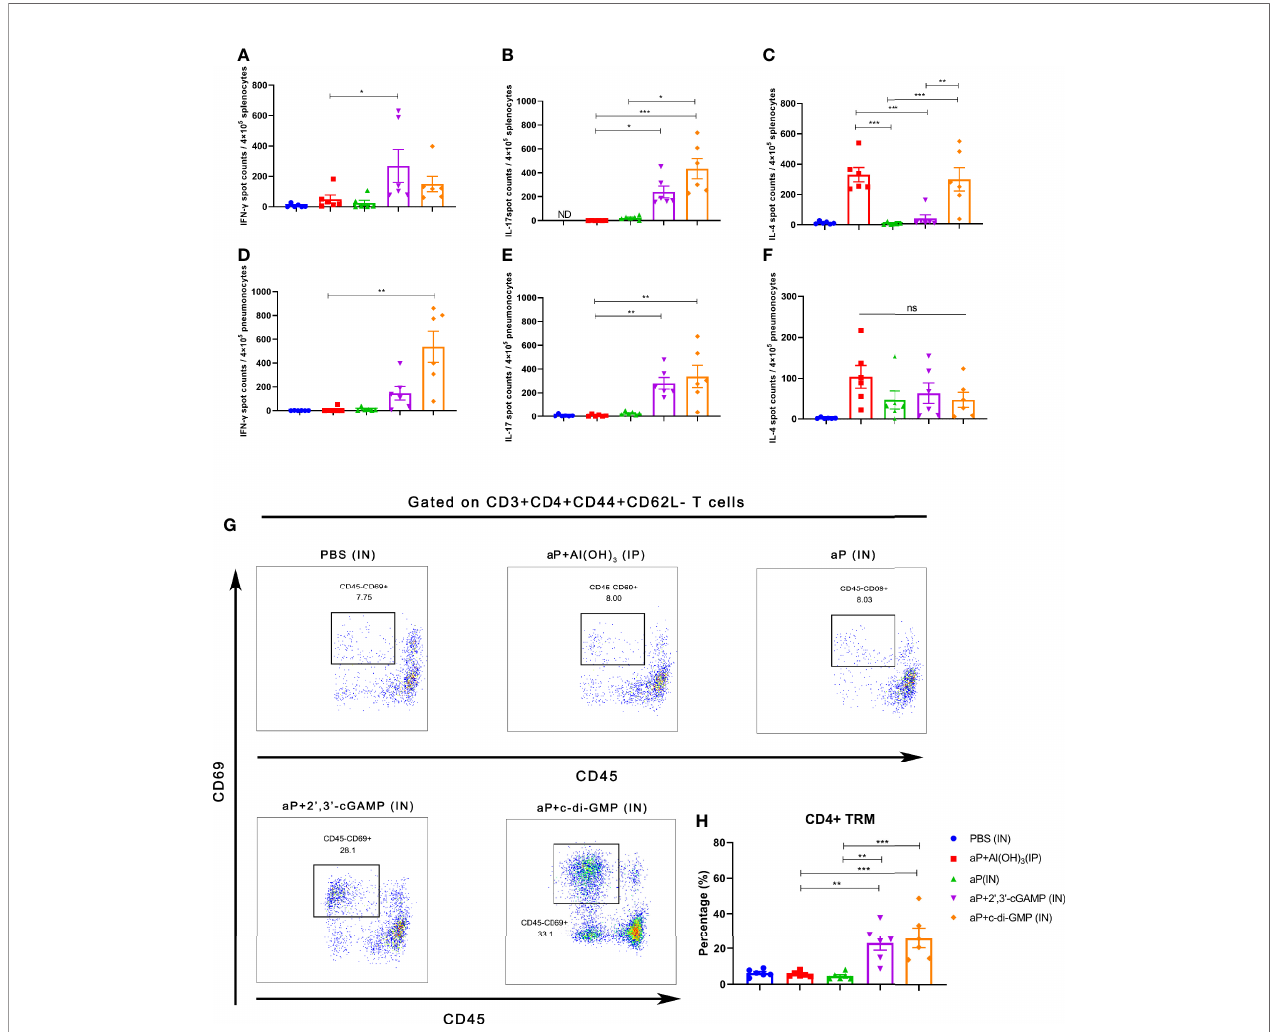
FIGURE 4 | Intranasal immunization with a CDN-adjuvanted aP vaccine induces strong systemic and mucosal cellular immune responses and potent TRM cells. (A – C) Splenocytes were assayed by ELISpot assay for IFN- g (A) , IL-17 (B) , and IL-4 (C) cell production after restimulation with the antigens PT (2 m g/mL), FHA (2 m g/mL), and PRN (2 m g/mL) (n=6 mice per group). (D-F) Lung tissues were assayed by ELISpot assay for cell production of IFN- g (D) , IL-17 (E) , and IL-4 (F) after restimulation with the antigens PT (2 m g/ml), FHA (2 m g/ml), and PRN (2 m g/ml) (n=6 mice per group). (G, H) Mice were i.v. injected with an anti-CD45 antibody 10 min prior to euthanasia. The lungs were harvested, and lung mononuclear cells were stained with mAbs speci fi c for CD3, CD4, CD44, CD62L, and CD69 for fl ow cytometric analysis. The results are expressed as CD4+ tissue resident cells (TRM): CD3+CD4+CD44+CD62L-CD45-CD69+; representative fl ow cytometry gating strategies for CD4+ TRM cells in the lungs are shown in Supplementary Figure 2 (n=6 mice per group). Representative dot plots from fl ow cytometry analysis in (G) show the identi fi cation of CD4+ TRM cells. The relative proportion of CD4+ TRM cells in the lung tissues induced by different vaccines is shown in (H) . Data are expressed as the mean ± SEM. “ ND ” indicates that no individuals in this group had detectable levels. The P value is indicated as follows: * P < 0.05, ** P < 0.01, *** P < 0.001, ns, no signi fi